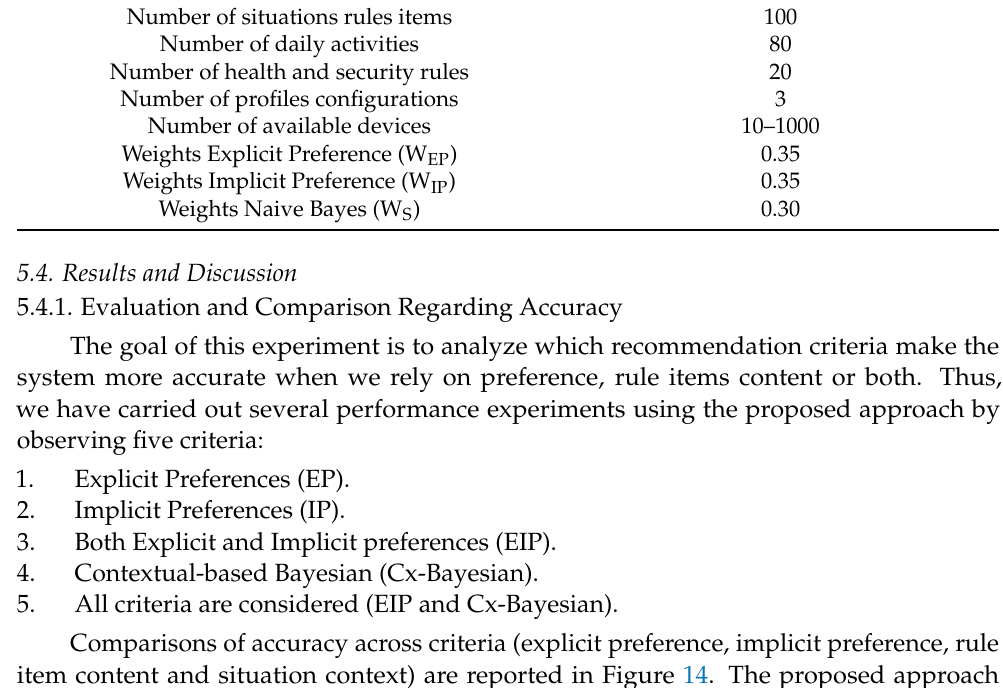
Table 6. Configuration setup.